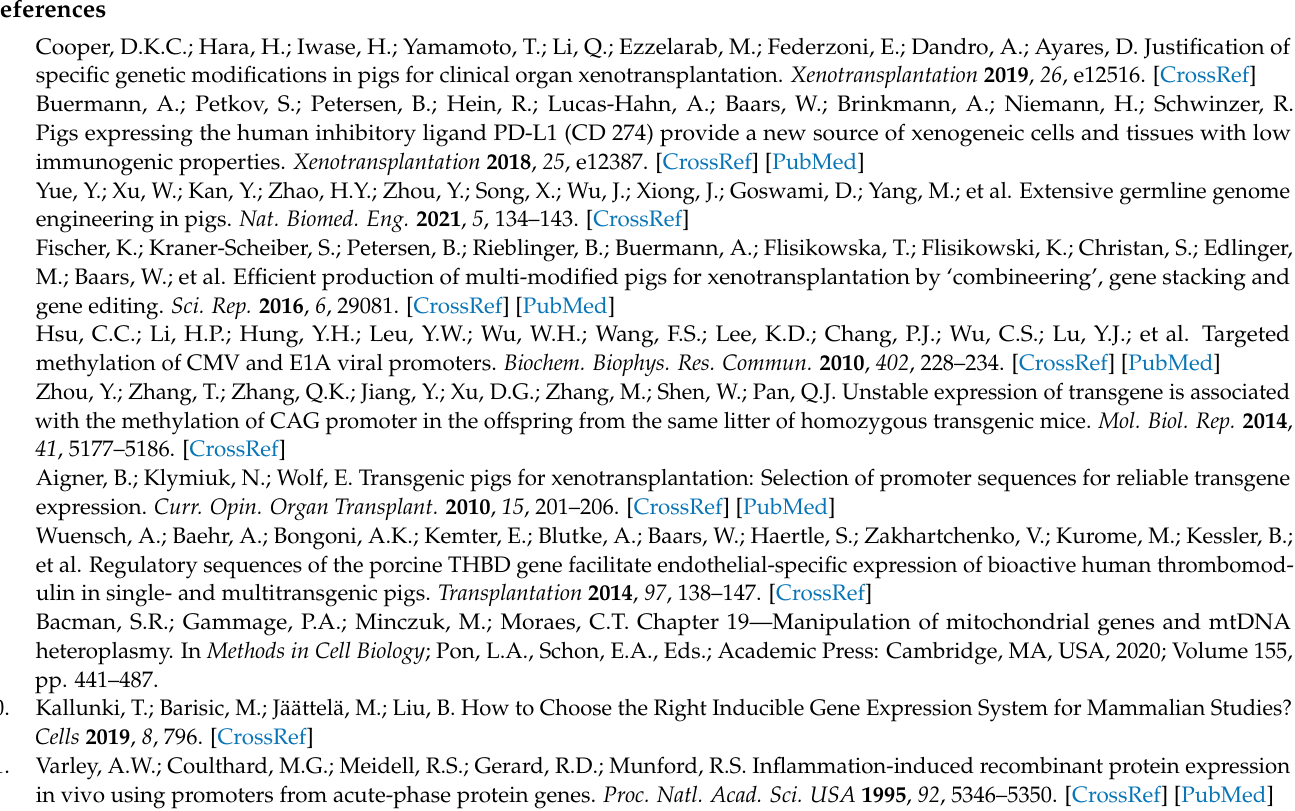
(D20), Table S1: Putative transcription-factor binding sites in the selected pEF1 α promoters compared with those of the hEF1 α